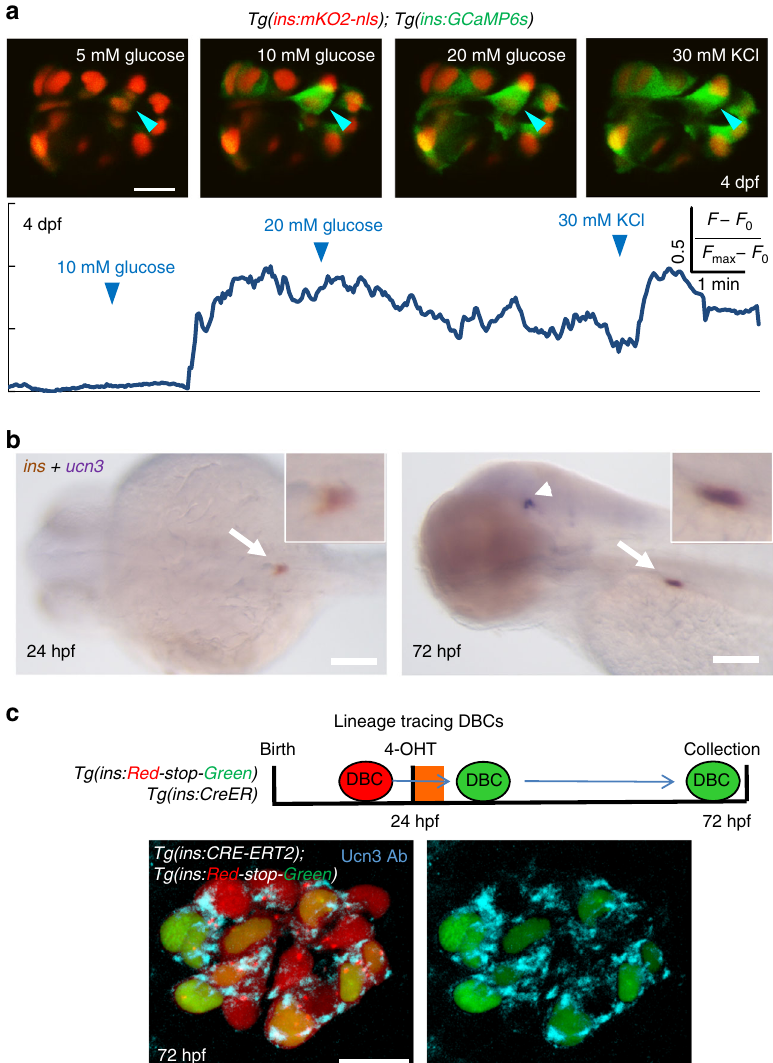
Fig. 3 Beta-cells in the primary islet become functional during early development. a Glucose responsiveness of larval beta-cells at 4 dpf. Top — islets from Tg (ins:GCaMP6s) ; Tg(ins:mKO2-nls) animals were mounted ex vivo. Beta-cells ( red nuclei ) were stimulated with a glucose ramp consisting of sequential incubation with 5 (basal), 10, and 20 mM D -glucose, and depolarized via addition of 30 mM KCl. A representative beta-cell is marked with an arrowhead . Bottom — trace of normalized GCaMP6s- fl uorescence intensity over time for the beta-cell indicated in the top panels . In response to glucose stimulation, the cell showed strong fl uorescence; indicating glucose-stimulated calcium in fl ux. The fl uorescence reached its peak after addition of KCl. 60 ± 3% of the recorded beta-cells exhibited glucose-induced calcium in fl ux upon sequential incubation with 10 and 20 mM glucose ( n = 36 cells in fi ve islets) but not at basal concentrations. b Whole-mount, double in situ hybridization for insulin ( brown ) and ucn3 ( purple ). At 24 hpf, ucn3 transcripts were not detectable in the embryonic islet ( arrow ) (enlarged inset ). At 72 hpf (3 dpf), beta-cells exhibit double positivity for insulin and ucn3 ( arrow ) (enlarged inset ). Arrowheads point to ucn3 -expressing neurons at 72 hpf, as shown previously 38 . See also Supplementary Fig. 18 for single ucn3 in situ hybridization at 3 and 5 dpf. c The ins promoter drives Cre-ER T2 expression in beta-cells. CRE-mediated recombination excises the fl oxed mCherry in Tg(ins:Red-Stop-Green) . Beta-cells that undergo successful recombination activate insulin:H2B-GFP-expression. To label DBCs speci fi cally, 4-OHT was applied from 24 to 30 hpf. At 72 hpf, a majority of the traced beta-cells (H2B-GFP-positive) showed Ucn3-immuno fl uorescence (confocal projection) ( n = 5 islets). Scale bars in a , c , 10 µ m; 1 mm in